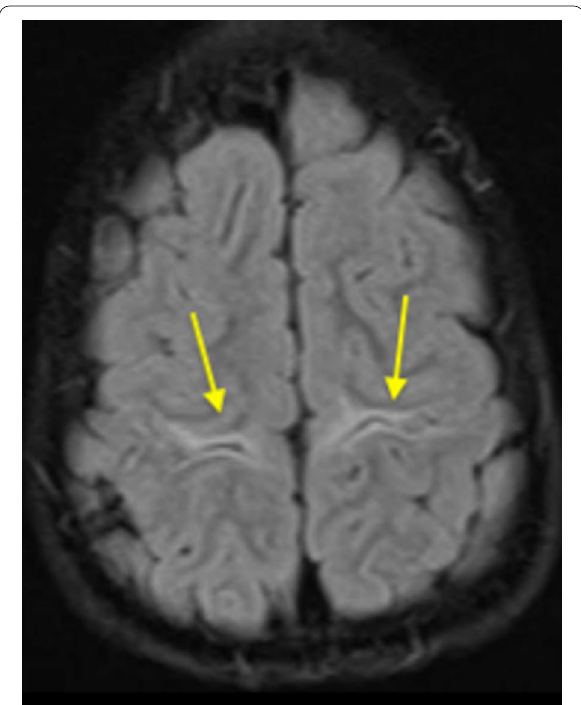
Fig. 2 The mild subtype of perirolandic (yellow arrows) primary motor cortex and postcentral gyrus involvement